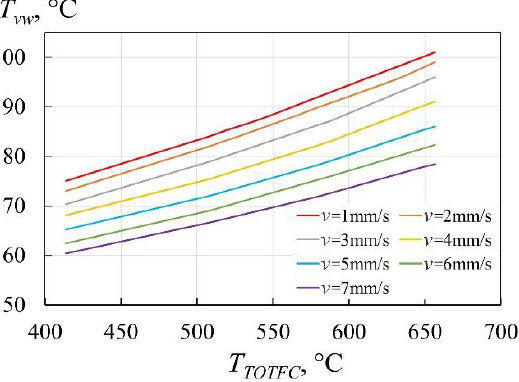
Figure 3. The dependence of T vw on T TOTFC at varied traction speeds ( ν ) (the wavelength of laser radiation is 980 nm, the inner vein diameter is 5 mm).